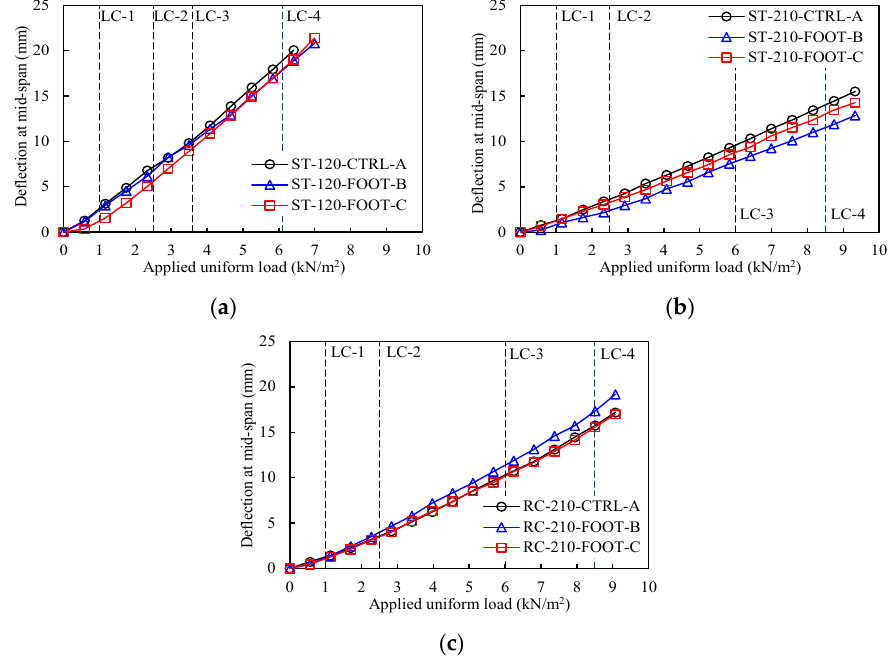
Figure 6. Applied load–deflection response. ( a ) Group-1. ( b ) Group-2. ( c ) Group-3. The deflection distributions of the specimens in each group are as shown in Figure 7; they were similar for all specimens regardless of the deck plate type and height of the lattice truss girder. During the final loading step, there was a deflection average of 6.73 mm at the points on both ends of RC-210-CTRL-A, RC-210-FOOT-B, and RC-210-FOOT- C, that is, the RC beam point specimens; this was approximately 2.37 times higher than that of the steel beam point specimens. It can be assumed to have been caused by shrink- age deformation in the wood. ( a ) ( b ) ( c ) Figure 7. Deflection distributions at the final loading step. ( a ) Group-1. ( b ) Group-2. ( c ) Group-3.